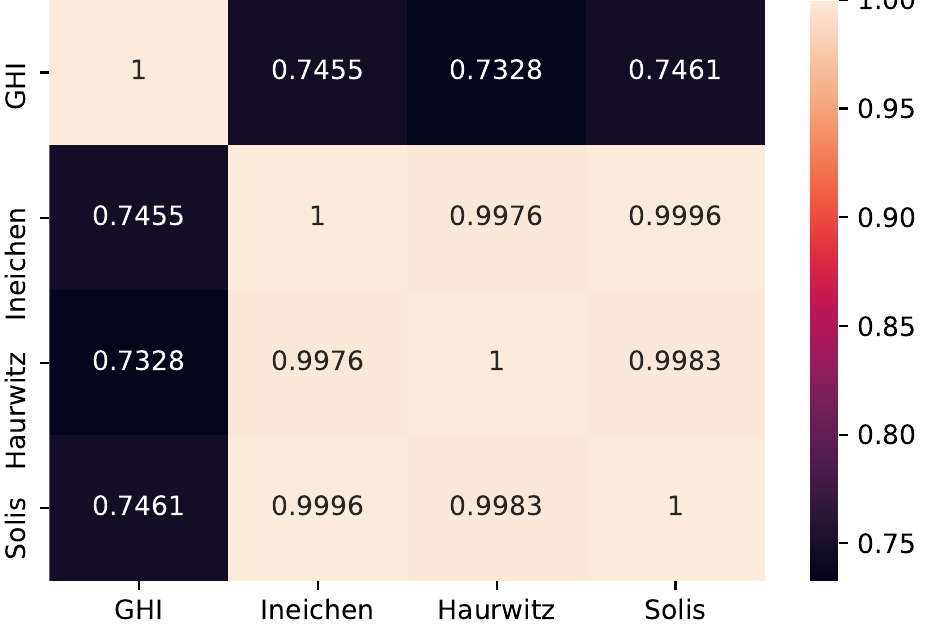
Figure 10. Correlation matrix between GHI and clear sky